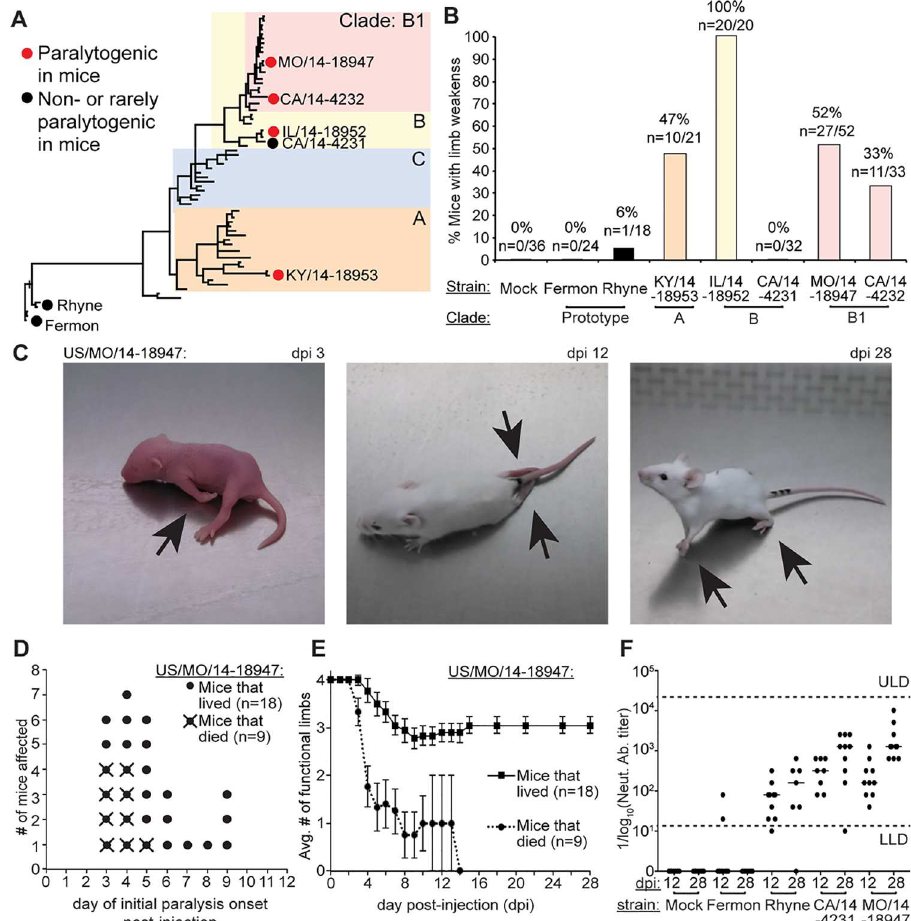
Fig 1. EV-D68 causeslimb paralysis in neonatal mice. ( A ) Phylogenetictree of EV-D68 basedon VP1 sequenceshowingeach strain tested in this study. ( B ) Bar graph showingthe percent of mice with paralysis followingintracerebral injectionwith each EV-D68 strain or control media. ( C ) Examples of limb paralysis (arrows) in 3 different mice followingintracerebral injectionof MO/14-18947. Left–day post-infection 3 (dpi 3), center–dpi 12, right–dpi28. ( D ) Day of paralysisonset in mice after intracerebral injectionwith MO/14-18947. Mice that died (n = 9 circles with “X”) generallyhad earlieronset of paralysisthan mice that lived (n = 18 circle). ( E ) Average numberof functional(non-paralyzed) limbs in mice followingintracerebral injectionwith MO/14-18947 in mice that lived (solid line, squares)and mice that died (dotted line, circles). Error bars representthe standard error of the mean (SEM). ( F ) Serum anti-EV-D68neutralizing antibody titer in mice (reciprocal serum dilution)followingintracerebral injectionwith MO/14-18947at dpi 12 and dpi 28 (n = 10), Fermon (n = 8–10), Rhyne (n = 7–10), CA/14-4231 (n = 8–10) or mock (n = 8). The line in each group on the graph represents the mediantiter. Lower limit of assay detection(LLD) of 1:10 and upper limit of assay detection(ULD) of 1:10,240are indicatedby the dotted